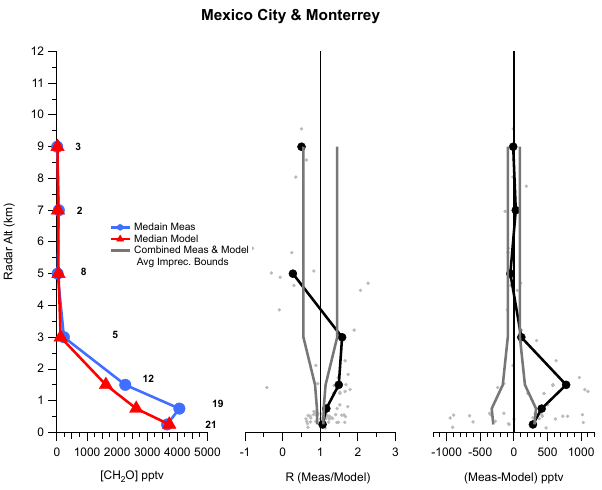
Fig. 6. Time coincident comparisons on hydrocarbon time base over Mexico City and Monterrey during the 1st phase of INTEX-B. This plot has the same format as Fig. 5. The outlier ratio between 6 and 8km ( R = 4 . 7) is an artifact of the small number of points (2) and was omitted from the center plot to preserve resolution but was kept in the difference plot since the difference was small. The combined imprecision limits could not be determined for the 4–6, 6–8, and 8–10km bins and thus the values for the 2–4km bins are repeated here for the higher altitude bins.